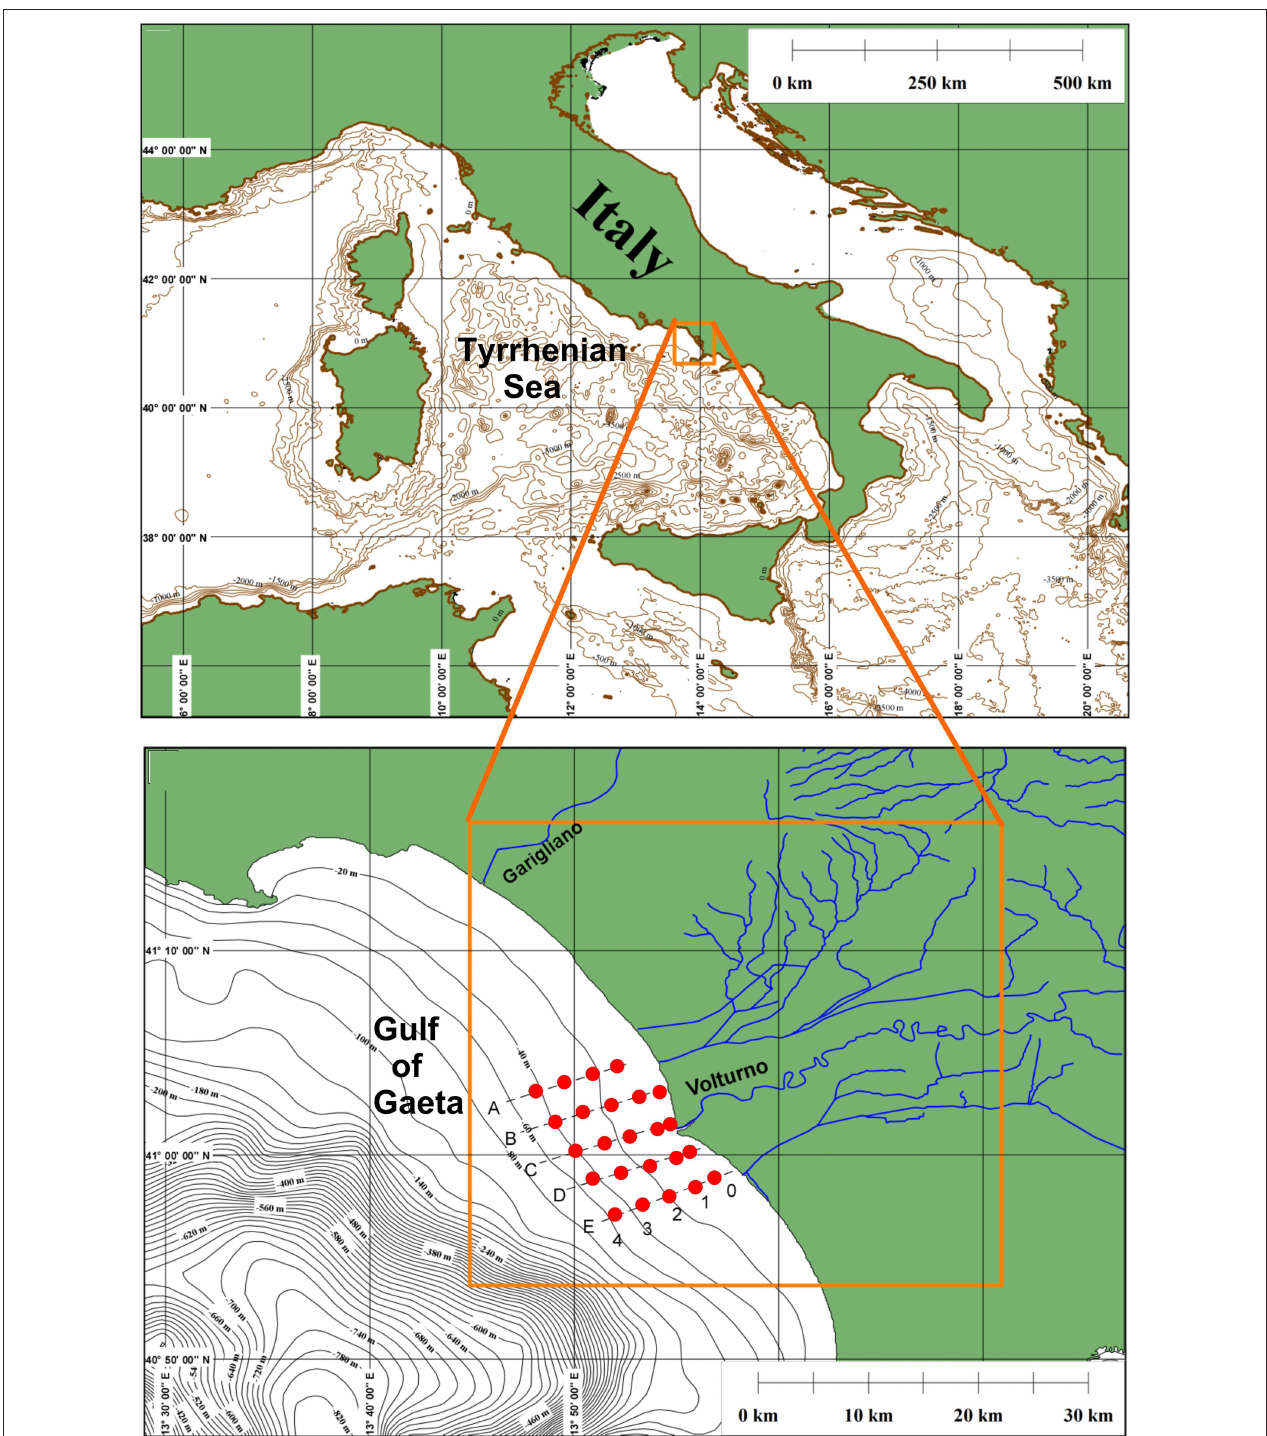
FIGURE 1 | The model domain in the Tyrrhenian Sea (orange square) with bathymetry and CTD casts (red dots).